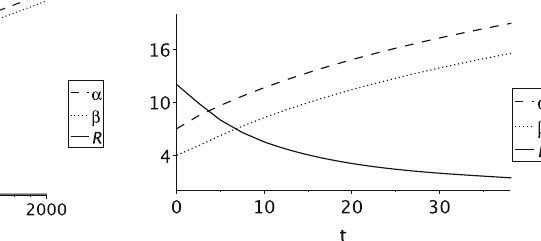
11 . 99901 is found from Eq. (11). The values of H 1 = H 2 (cid:4) 0 . 02461 coincidewiththosefoundfromexpression(17).TheLagrangianparam- eters are k = 500 , a = 200 , c = − 0 .